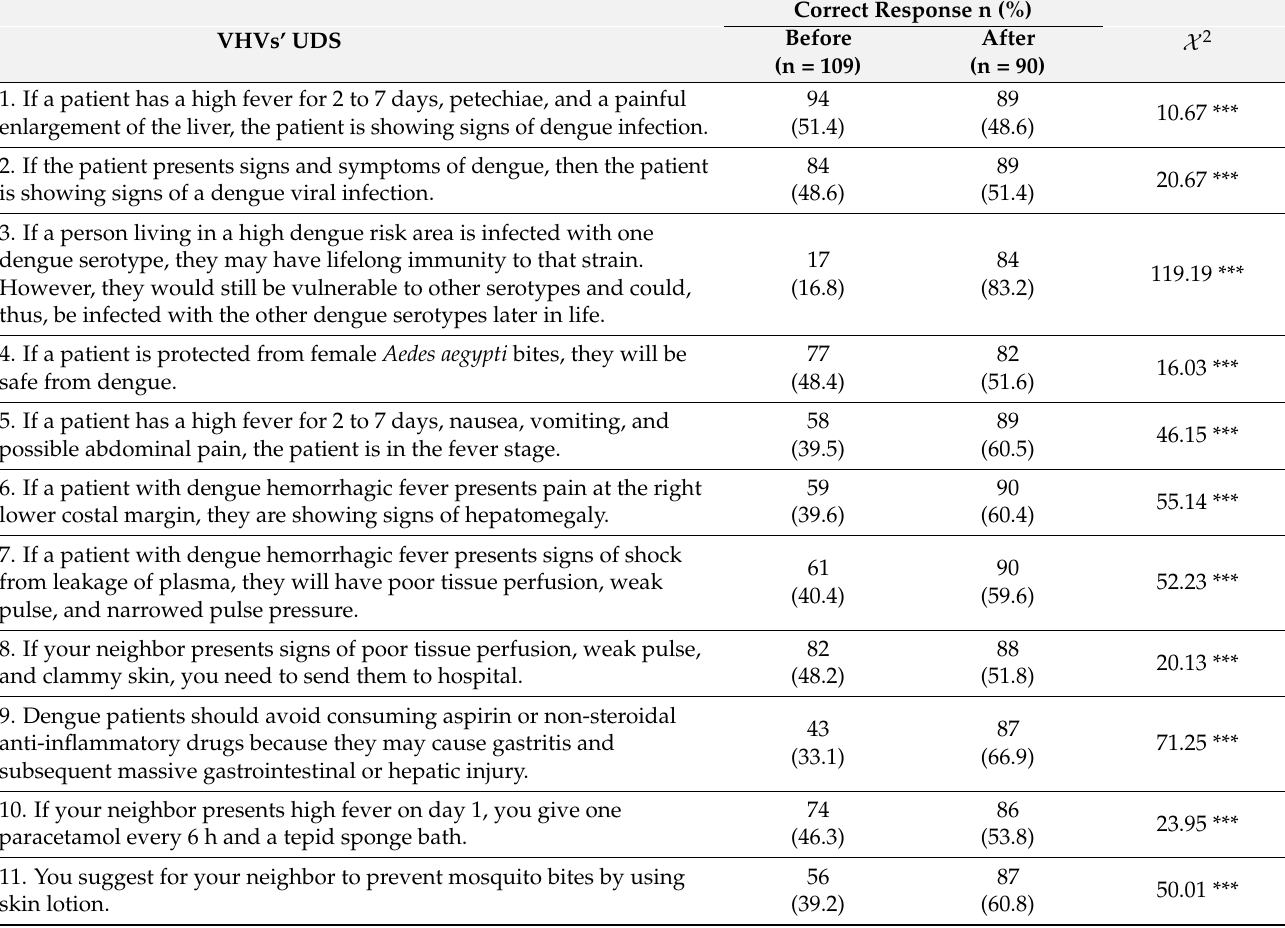
Table 4. Comparison of correct response rates regarding the UDS for VHVs before and after imple- mentation of the training